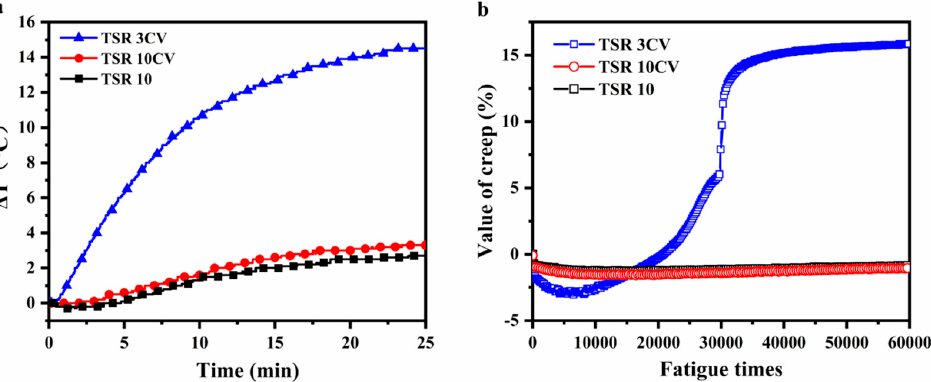
Figure 6. ( a ) Temperature rise curve of vulcanizates; ( b ) Creep and fatigue life curve of vulcanizates.